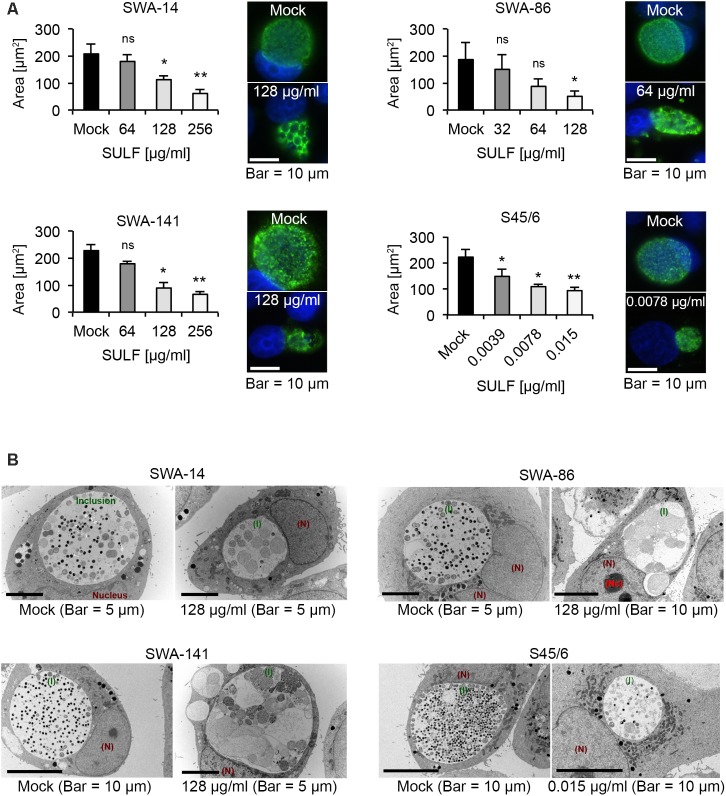
The effects of sulfamethoxazole exposure. (A) Shown are bar graphs comparing the average inclusion size of sulfamethoxazole-treated cultures to the mock-exposed cultures (left; mean ± SD) as well as representative immunofluorescence images of the inclusion morphology of the untreated control (right, top) and the MICTP (right, bottom) for strains SWA-14, SWA-86, SWA-141, and S45/6 at 48 h post infection. Asterisks indicate a statistically significant difference between the sulfamethoxazole-exposed cultures and the mock by both Student’s t-test and the Welch t-test (ns, not significant; ∗p < 0.05; ∗∗p < 0.01). Three independent experiments were performed (n = 3). (B) Representative transmission electron microscopy (TEM) images are shown for each strain wherein the mock is presented on the left part of the panel and sulfamethoxazole-exposed cultures are presented on the right. Inclusions are indicated in green (I), the nucleus in dark red (N) and, if applicable, the nucleolus in bright red (Nc). Cultures were fixed at 48 h post-infection for processing for TEM analysis.